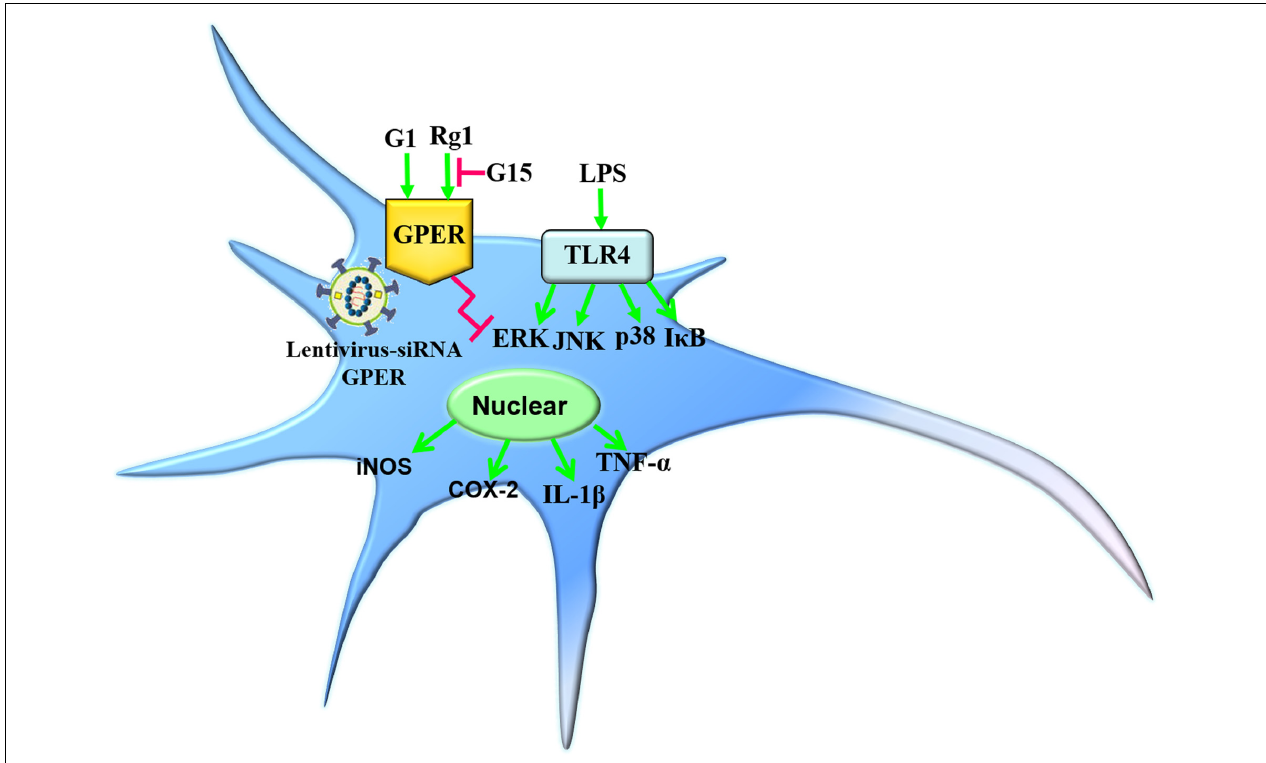
FIGURE 8 | Simplified models depicting the anti-inflammatory effects of Rg1 or G1 against LPS-induced microglia activation. Rg1 and G1 exerted inhibitory effects against the LPS-induced neuroinflammatory response. The pharmacological blockade and lentivirus-mediated siRNA knockdown of GPER significantly inhibited the protective effects of Rg1 or